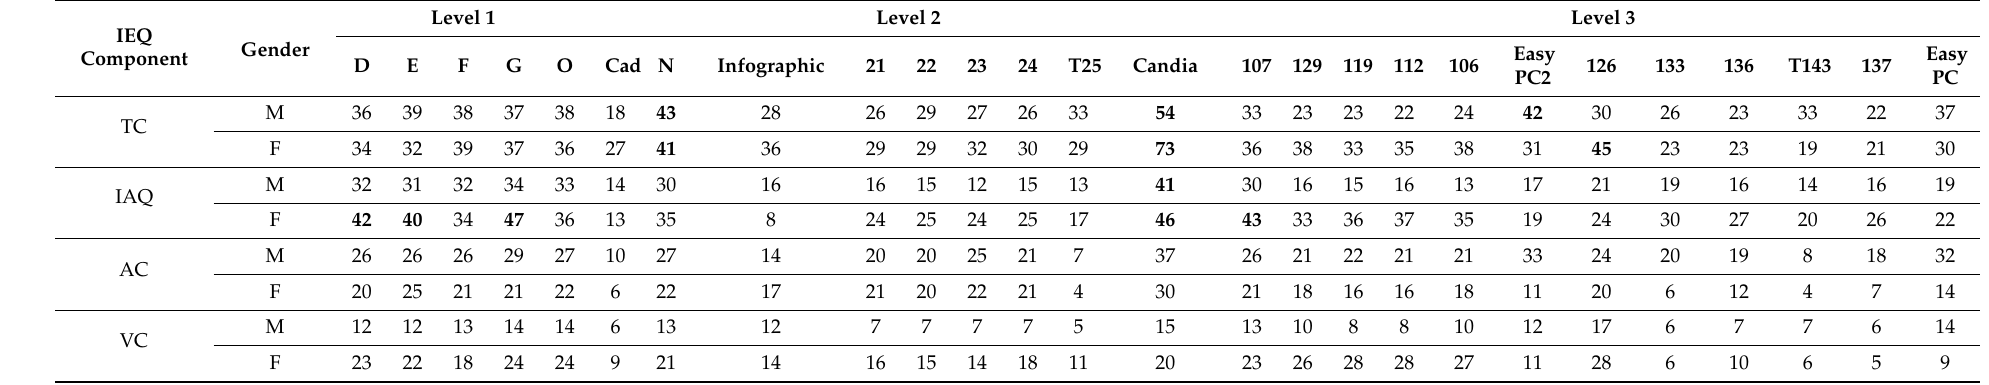
Table 3. Percentage of dissatisfied for males and females in 26 investigated classrooms. All values in bold are referred to percentages of dissatisfied greater than 40%. TC (Thermal Comfort), IAQ (Indoor Air Quality), AC (Acoustic Comfort), VC (Visual